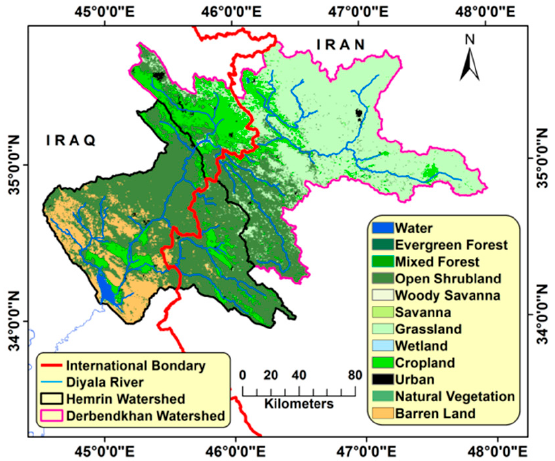
Figure 2. Shuttle Radar Topographic Mission (SRTM) digital elevation model (DEM) (90 × 90 m spatial resolution).